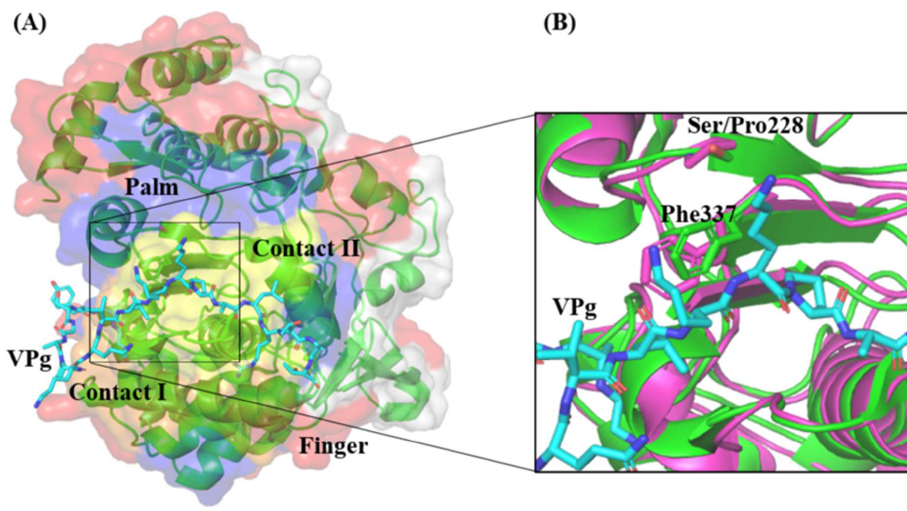
Figure 12. 3D polymerase–VPg (virus protein, genome-linked) complex. ( A ) 3D polymerase is shown in cartoon representation (green) and surface, while VPg is shown in sticks (cyan). The amino acids within the palm (blue) and finger (red) domains of 3D polymerase formed an interaction with VPg. These amino acids formed two major regions of the interface named as Contact I (orange) and Contact II (yellow). ( B ) Close-up view of the interface at Phe337. The model of EV-A71/SP was su- perimposed on the structure to depict the proximity of the S228P mutation to Phe337.